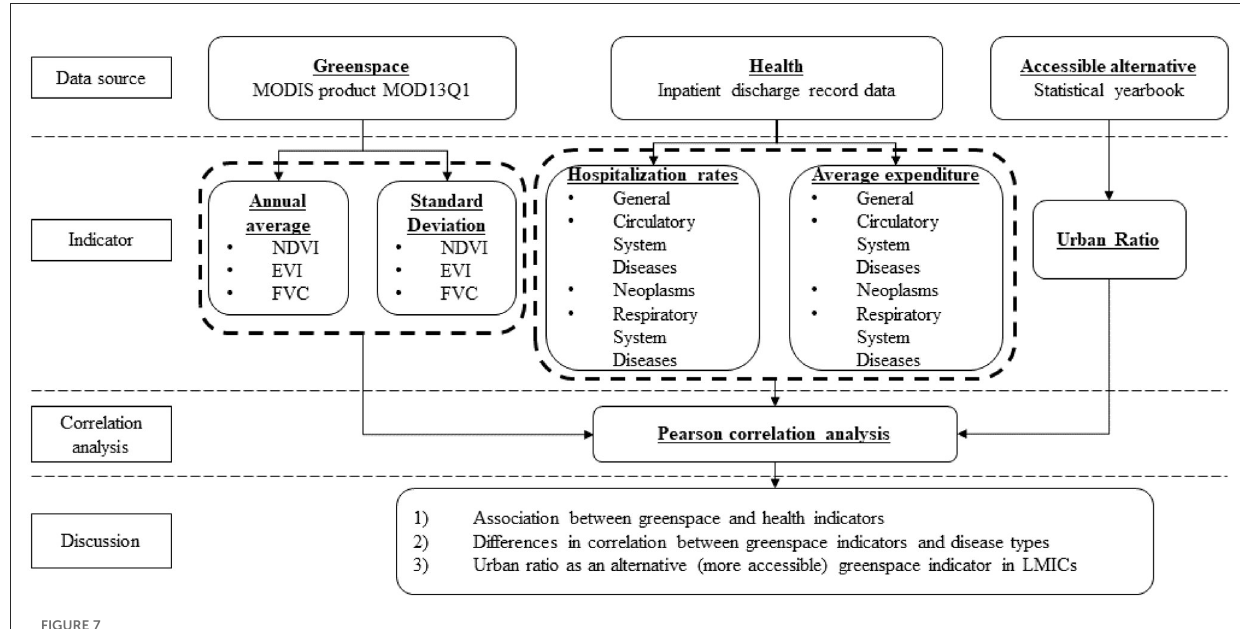
FIGURE7 Flow chart of research and